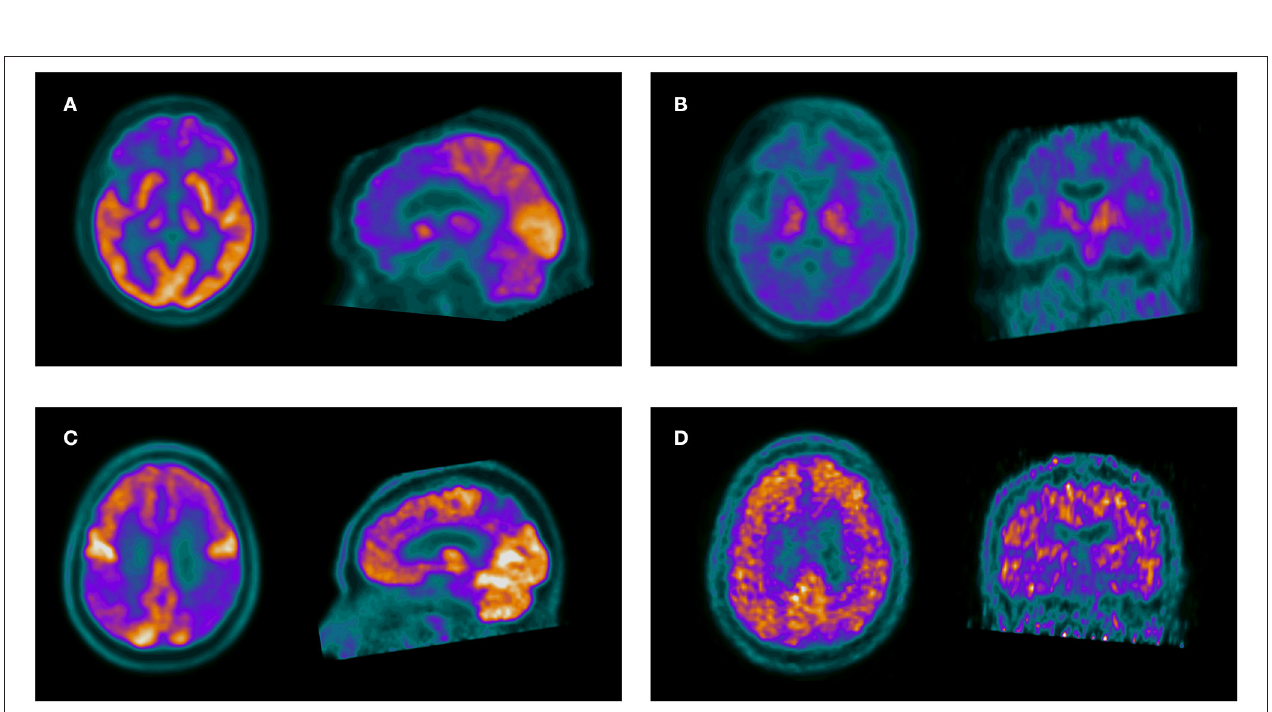
FIGURE 2 | The upper row shows a 56-year-old woman with memory complaints and change in behavior, referred with overlapping symptoms of AD, FTD and a baseline diagnosis of AD. Axial and sagittal slices of 18F-FDG PET (A) show frontal hypometabolism suggestive of FTD. Axial and coronal 11 C-PIB PET slices (B) are negative for amyloid deposition, confirming FTD. The lower row shows a 68-year-old male with symptoms of a non-fluent progressive aphasia. 18 F-FDG PET (C) shows posterior parietal and precuneus hypometabolism suggestive of AD. 11 C-PIB PET (D) confirms AD pathology.